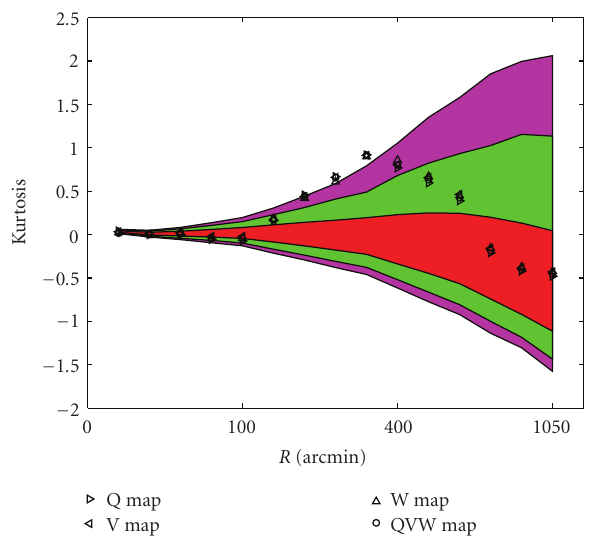
Figure 8: Frequency dependence of the excess of the kurtosis of the SMHW coe ffi cients. The plot shows the variation of the kurtosis as a function of the scale K R for cleaned CMB maps obtained from the WMAP data at three cosmological frequencies (Q-, V-, and W- bands), and for the optimal CMB cleaned map provided by WMAP, as noise-weighted combinations of the previous maps (the QVW map). The coloured regions represent, as for other figures, the 32%, 5% and 1% acceptance intervals provided by